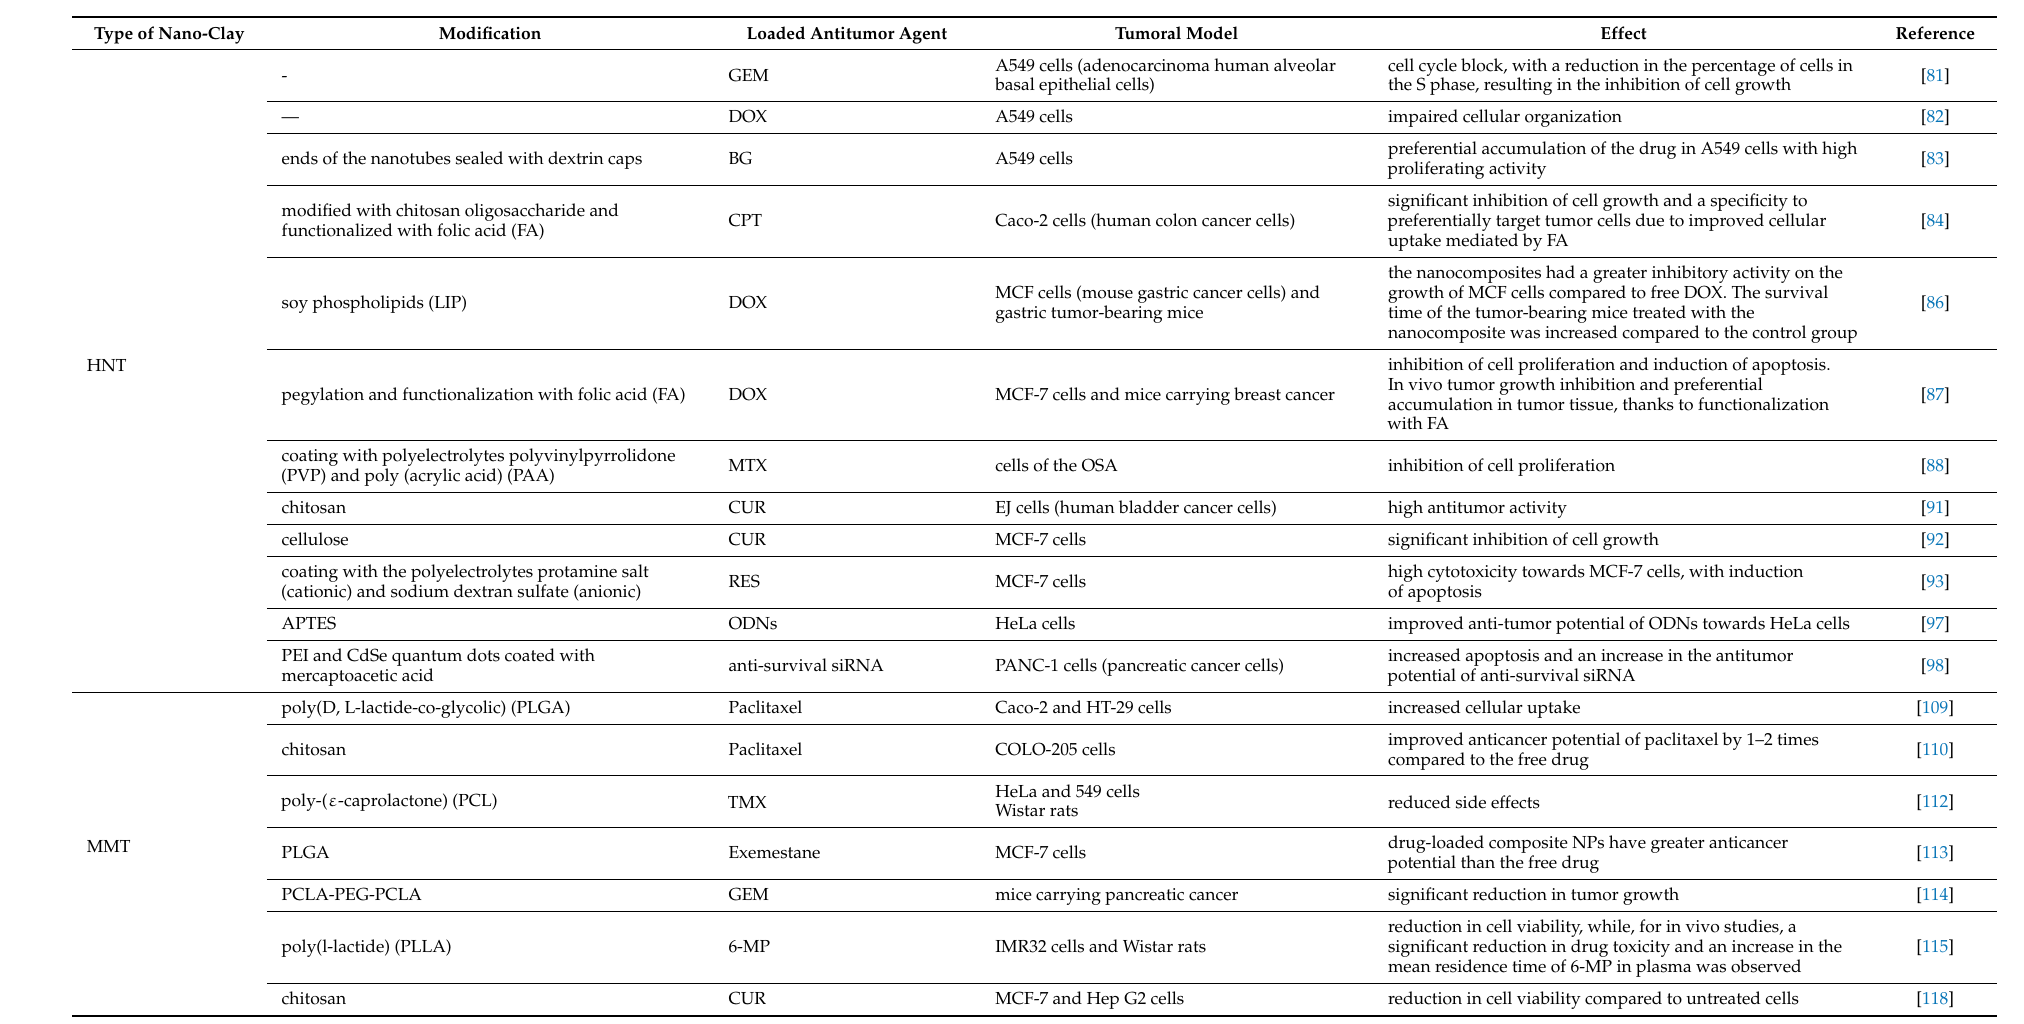
Table 1. Nano-clays in cancer